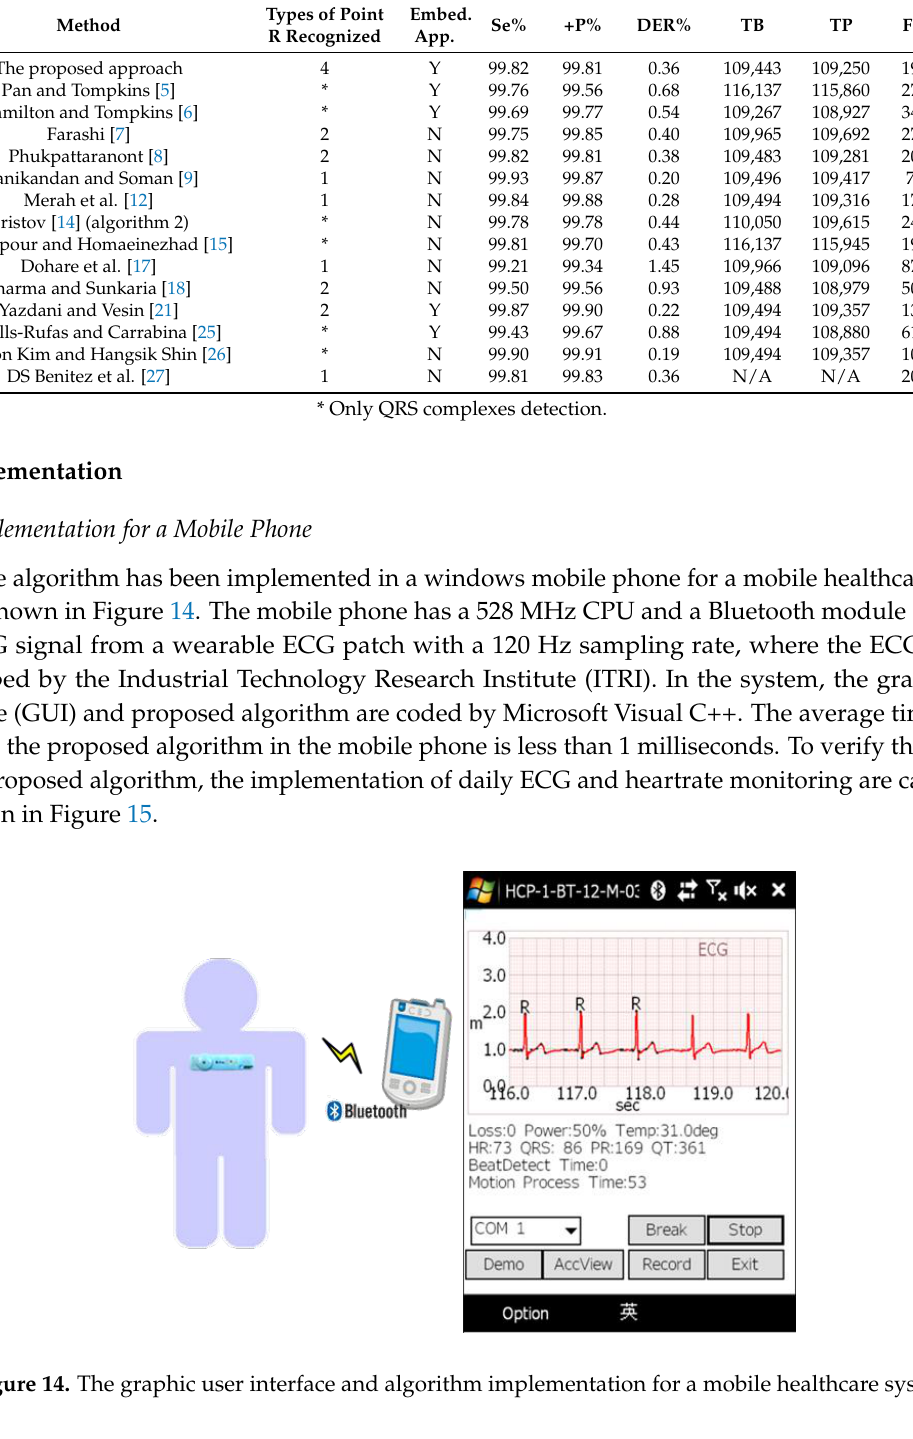
Figure 15. Implementation of daily ECG and heartrate monitoring using the proposed algorithm. 4.2. Implementation in An Embedded System To implement the healthcare IoT system, an efficient and low computational complexity algorithm is necessary to reduce transition envelopes and save storage space. The proposed algorithm is implemented in a wearable heart rate sensor developed by ITRI, shown in Figure 16, which contains a Corex-M3 MCU running at a frequency of 24 MHz. The average time cost of running the proposed algorithm in the Cortex-M3 MCU is less than 10 milliseconds.